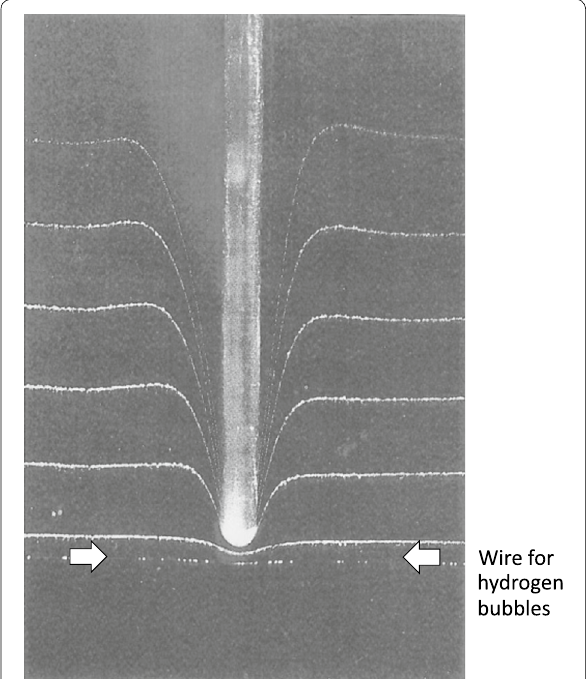
Fig. 6 Photograph of the experiment performed to visualize the water boundary layer in water using the hydrogen bubble method (Nakayama 2011). The plate thickness was 5 mm, and the flow veloc‑ ity was 0.6